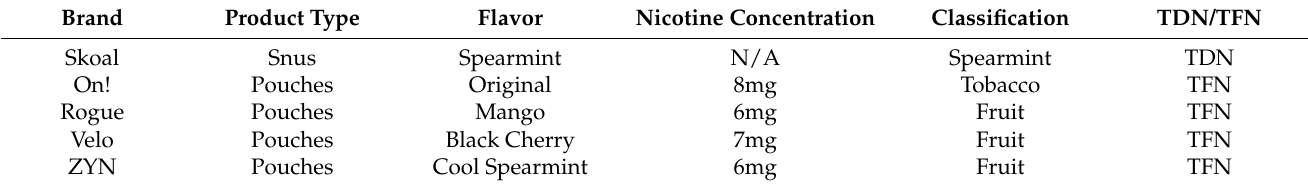
Table 2. Flavored Oral Nicotine pouches treated to Bronchial Epithelial cells (Beas2B/16 HBE)